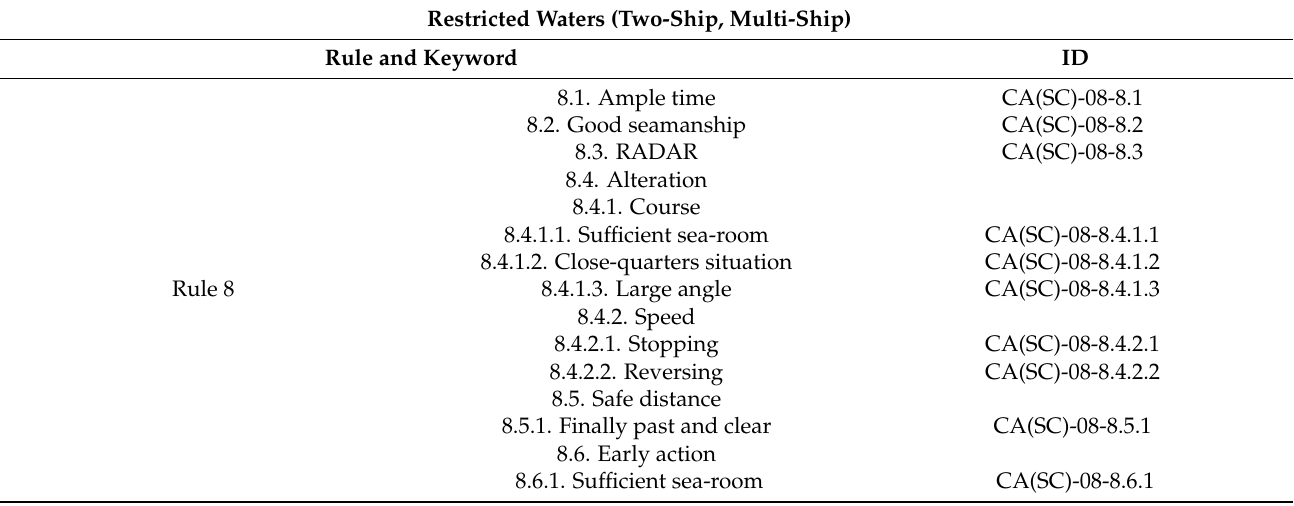
Table A7. Requirements specifications for collision avoidance action (speed and course).